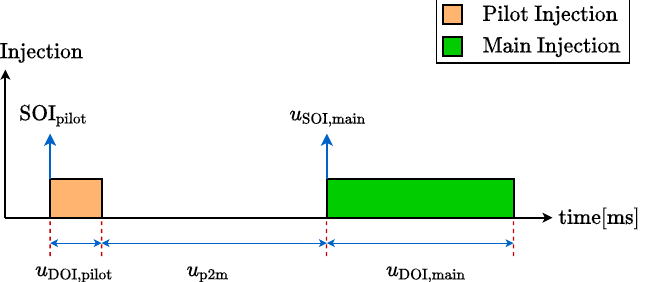
Figure 2. Structure of the proposed deep neural network model for engine performance and emission concentration modeling. LSTM: Long Short-Term memory, SOI: start of injection, DOI: duration of injection, p,fuel: fuel rail pressure, IMEP: indicated mean effective pressure, MPRR: maximum pressure rise rate, PM: Particle Matter, p2m: duration between end of pilot injection and start of main injection.